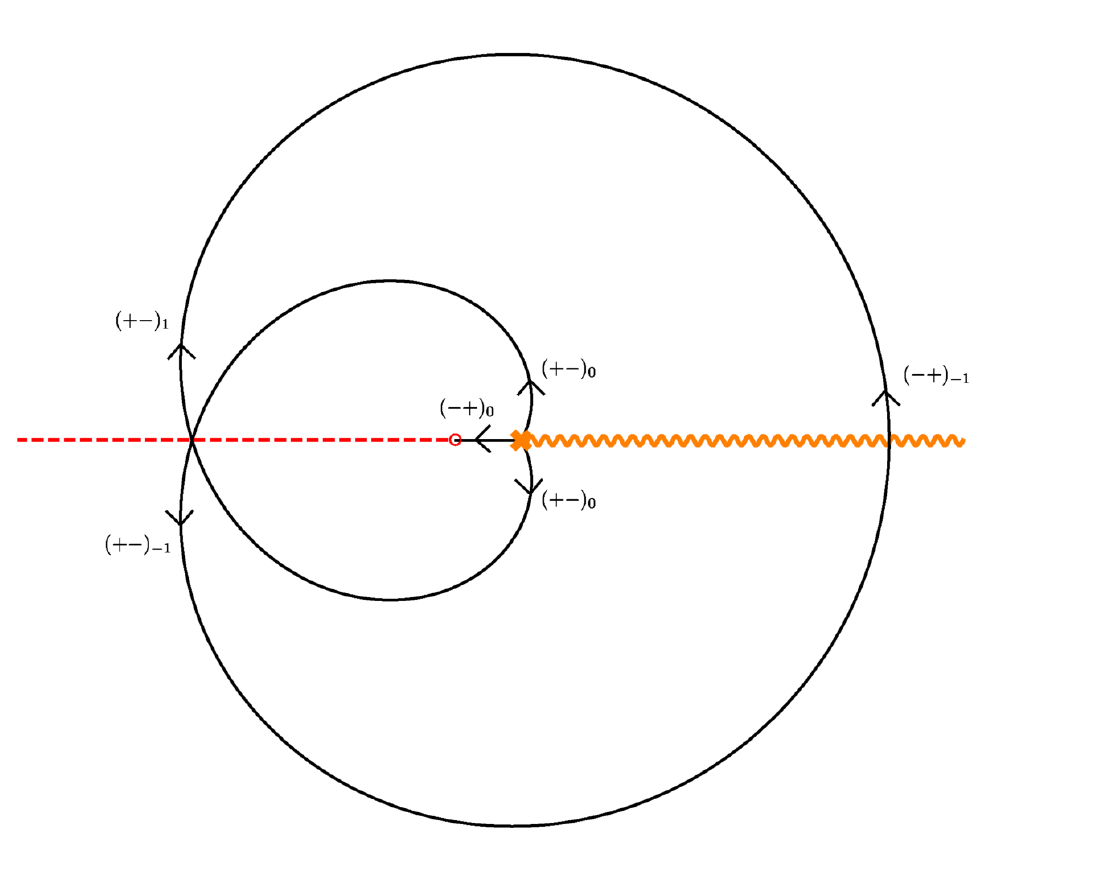
Figure 48. Sample network for the C 3 geometry.